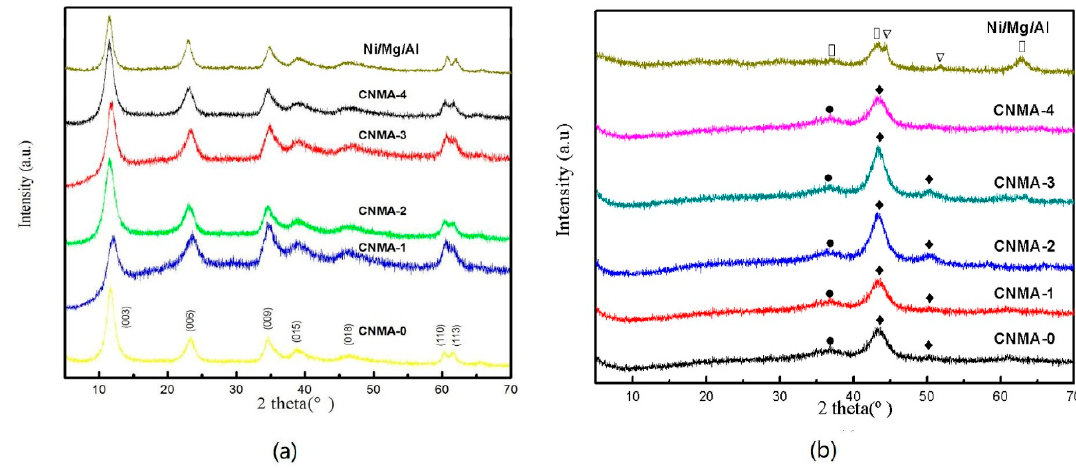
Figure 1. XRD of the Cu/Ni/Mg/Al precursors. ( a ) Calcined Cu/Ni/Mg/Al catalysts after being reduced at 300 °C; ( b ) ( ● ) Cu 2 O;( ♦ ) Cu 0 ; ( □ ) NiO; ( ▽ ) Ni.